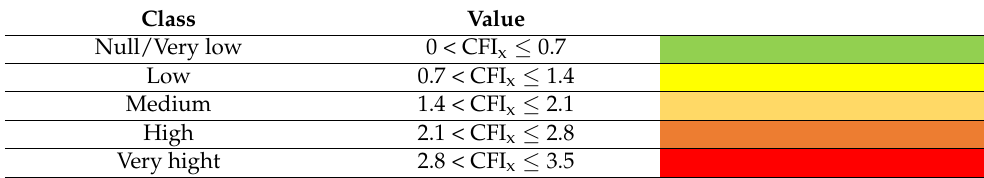
Table 4. The obtained five Forcing Index classes indicating − from green to red − an increase of forcing agents